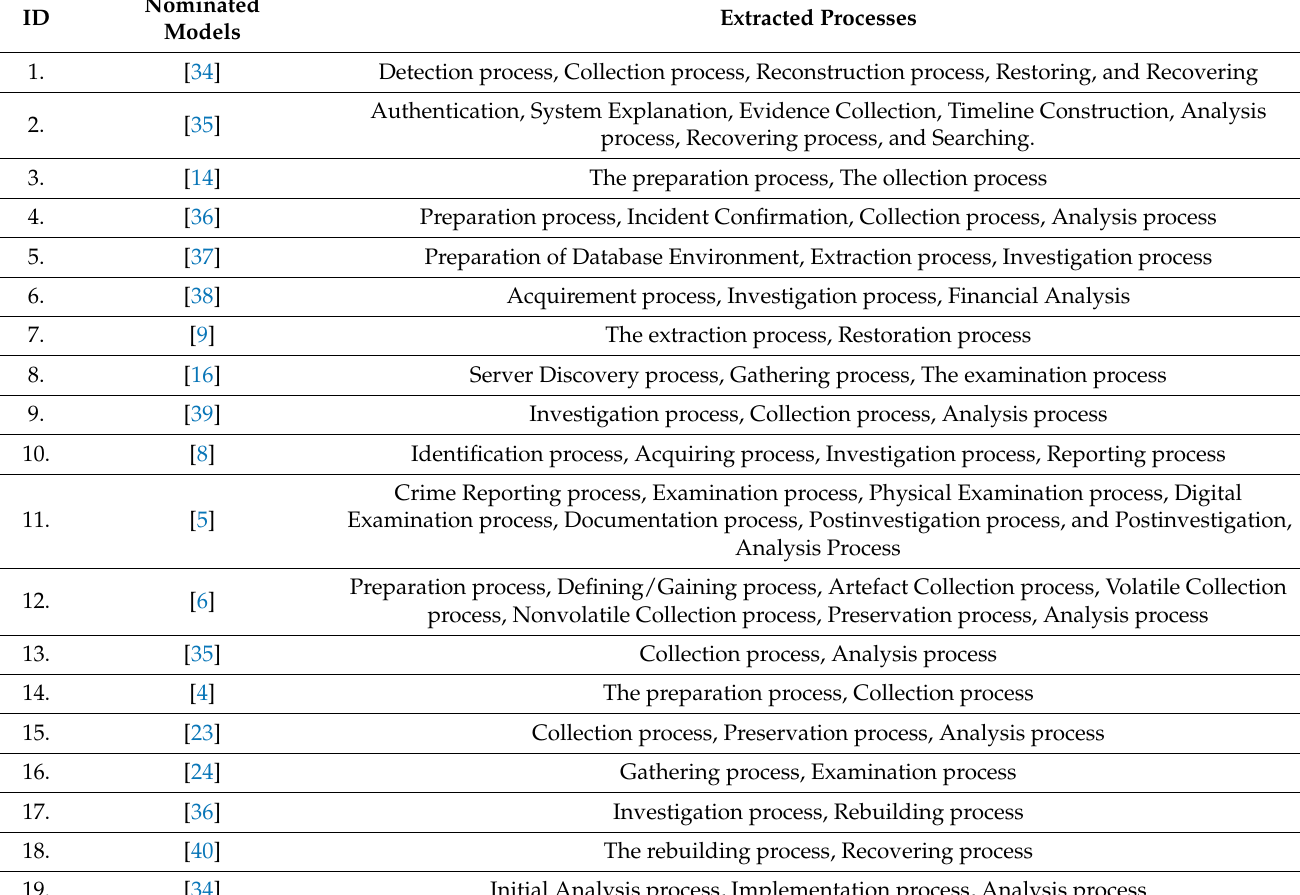
Table 1. Identified development and validation